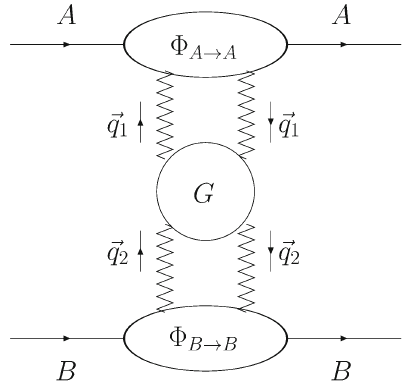
Fig. 1 DiagrammaticrepresentationoftheimaginarypartoftheBFKL